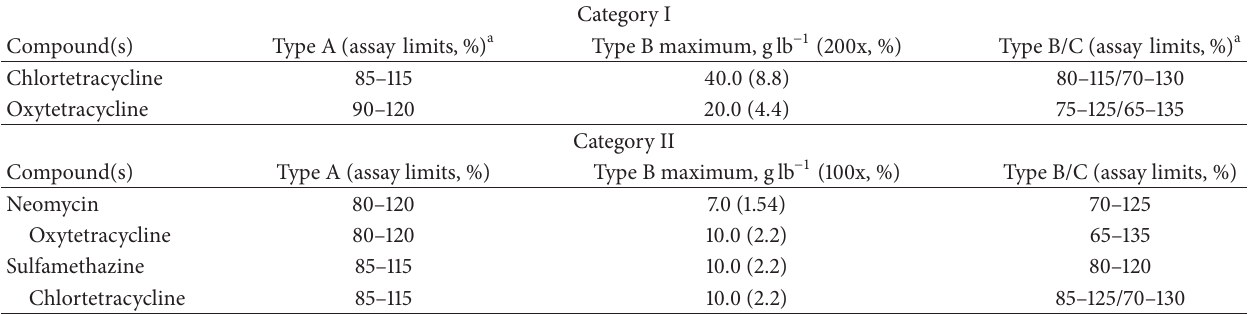
Table 2: Requirements of a medicated feed mill